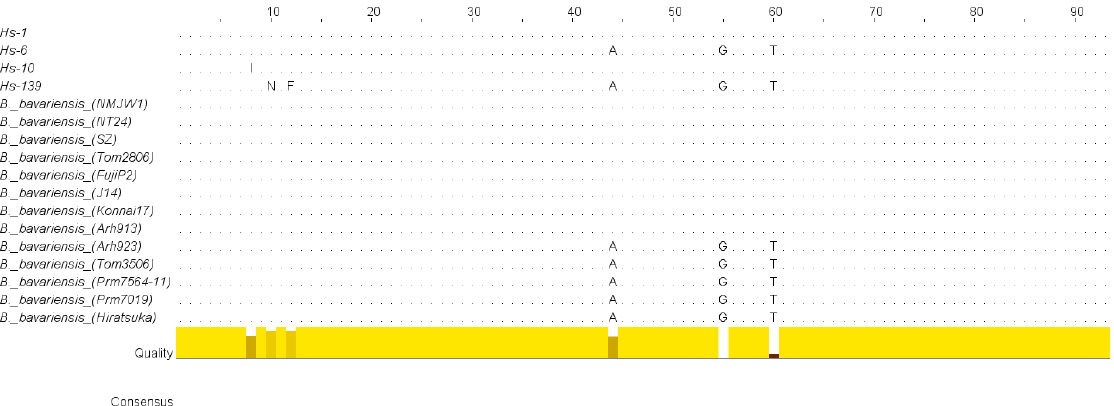
Figure 4. Comparison of amino acid sequences of P66 loop from various isolates of B. bavariensis . The quality annotation histogram reflects the likelihood of observing a mutation in any particular column of the alignment based on the BLOSUM62 matrix scores (for each column, the sum of the ratios of the two BLOSUM62 scores for a mutation pair, and each residue’s conserved BLOSUM62 score, are normalised and plotted on a scale of 0 to 1).